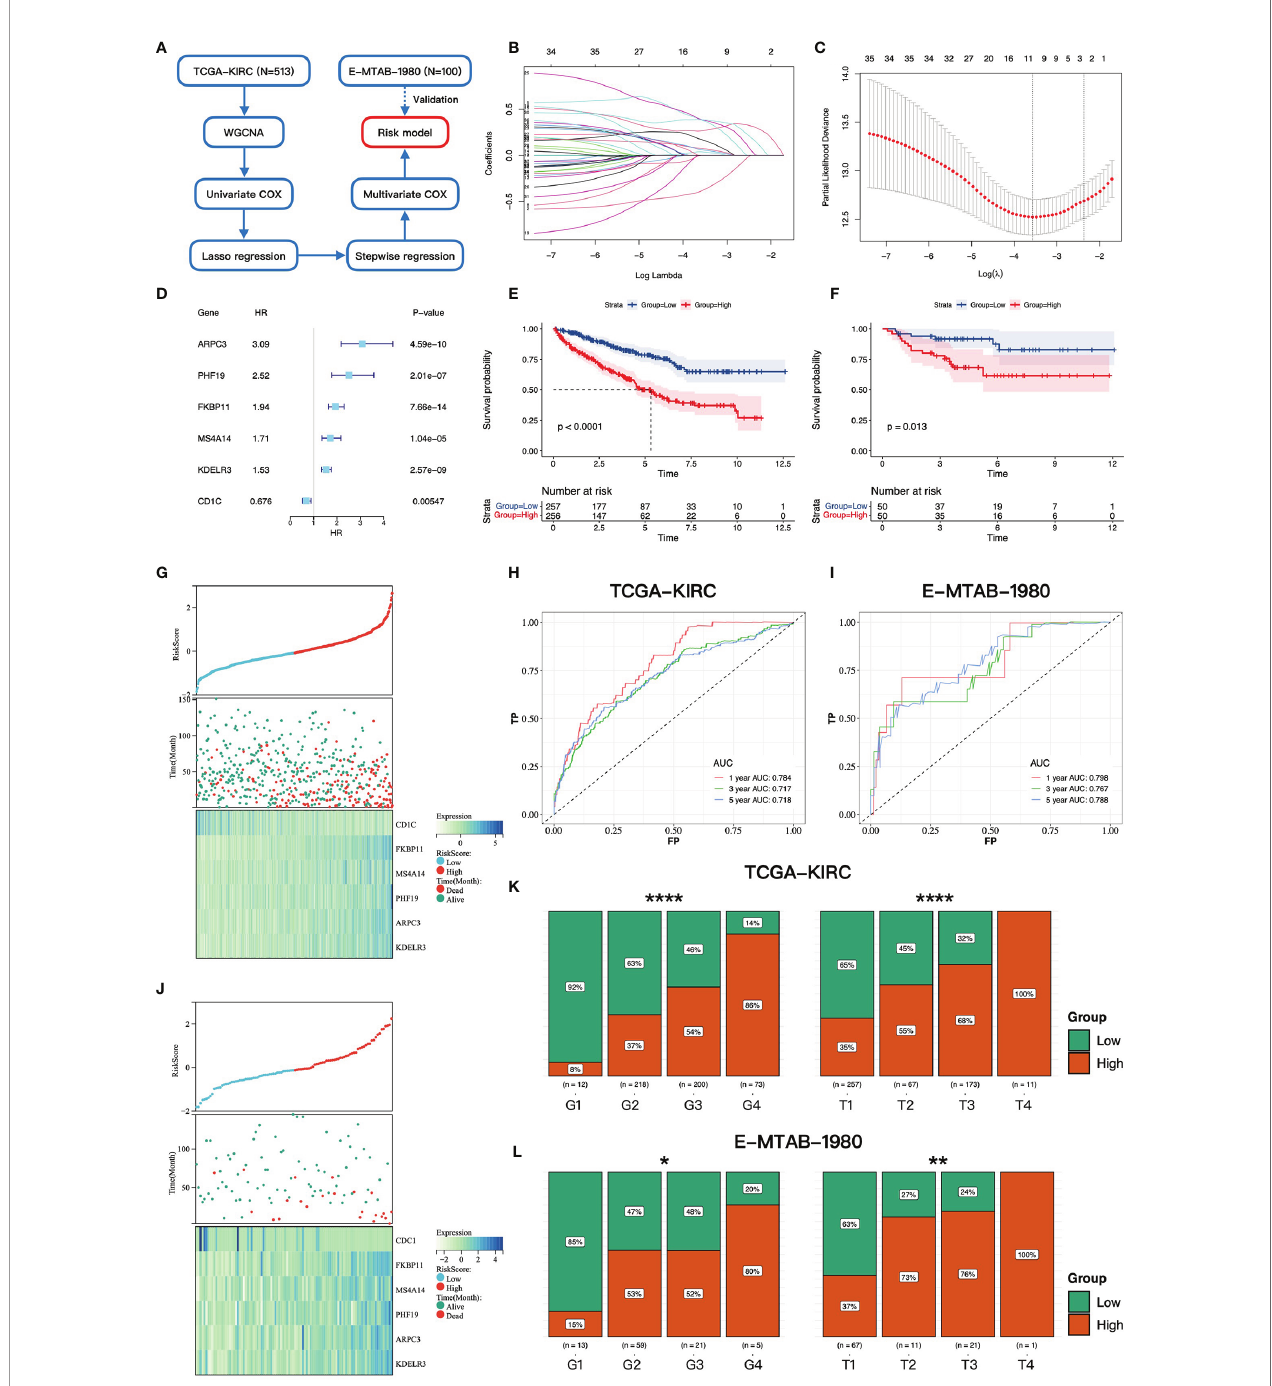
FIGURE 2 | Construction and validation of the gene signature. (A) The work fl ow of the constructing gene signature. (B) The coef fi cients of LASSO regression in the 10-fold cross validation based on 38 candidate genes. (C) Ten-fold cross-validation for tuning parameter selection. The dotted vertical lines are drawn at the optimal values by the minimum criteria and one-standard error criterion. (D) The forest plot of six hub genes based on univariate COX regression of overall survival in TCGA- KIRC cohort. (E, F) Kaplan – Meier survival curves of overall survival for patients in high- and low-risk groups in TCGA-KIRC cohort and E-MTAB-1980 cohort. (G, J) The distributions of the risk score and vital status in TCGA-KIRC cohort and E-MTAB-1980 cohort. (H, I) The time-dependent ROC curves at 1, 3, and 5 years based on the gene signature in TCGA-KIRC cohort and E-MTAB-1980 cohort. The proportion of high- and low-risk groups in different Fuhrman grades and pathology T stages in TCGA-KIRC cohort (K) and E-MTAB-1980 cohort (L) * 0.01 < p < 0.05; ** 0.001 < p < 0.01; ****p <